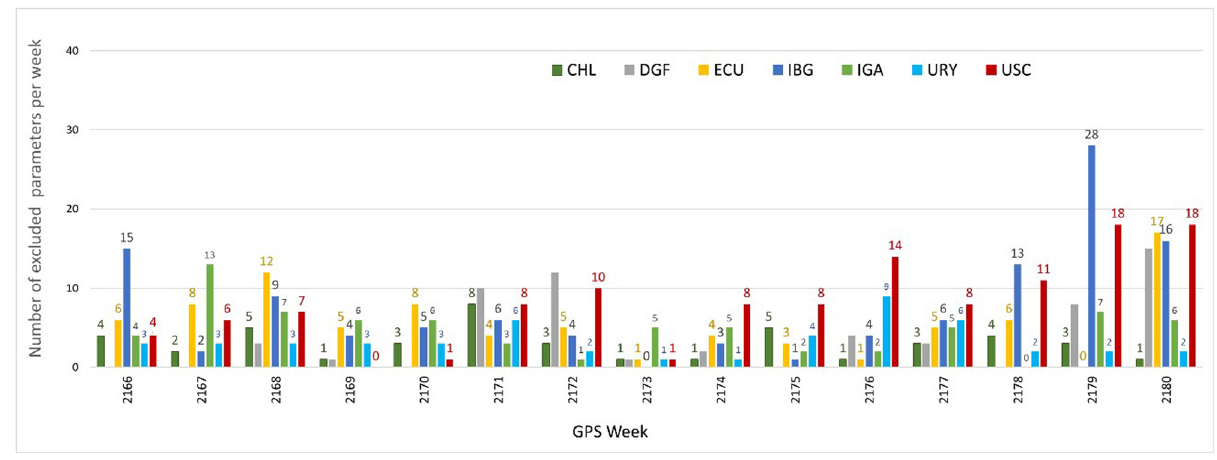
Figure 10: Number of tropospheric parameters excluded, per week, per AC, after improvement ( weeks 2,166 – 2,180 )